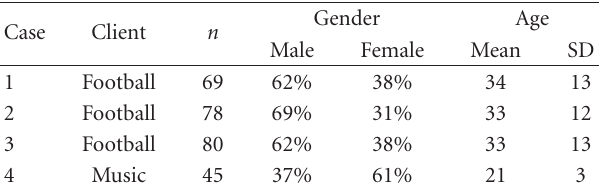
Table 1: User participant details.